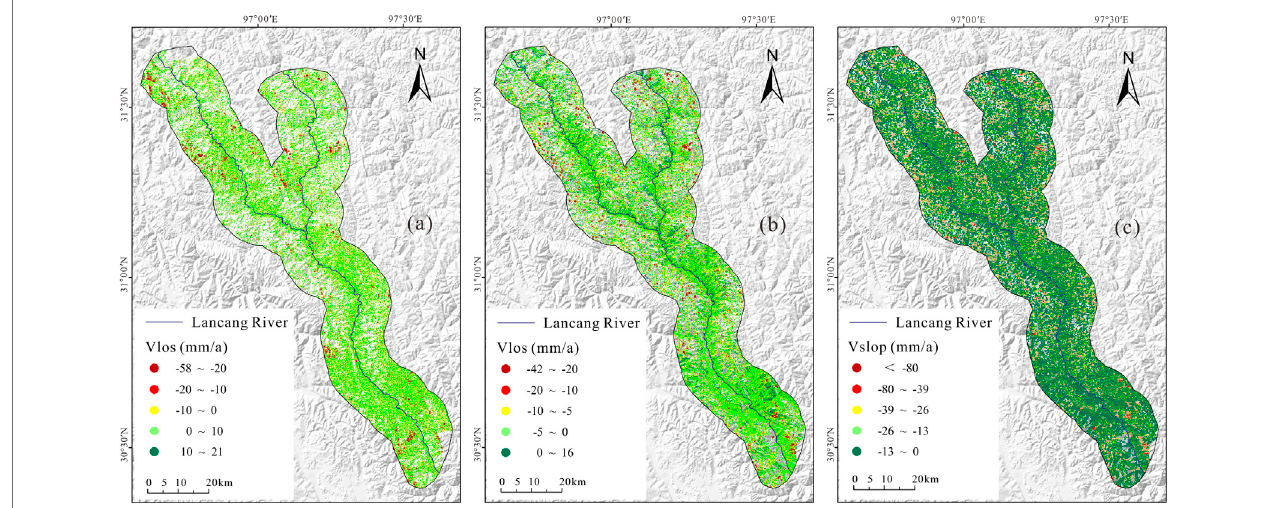
FIGURE 8 | (A) Deformation results in LOS direction obtained using Sentinel-1 data; (B) Deformation results in LOS direction obtained using RADARSAT-2 data; (C) Deformation results in slope direction after conversion.